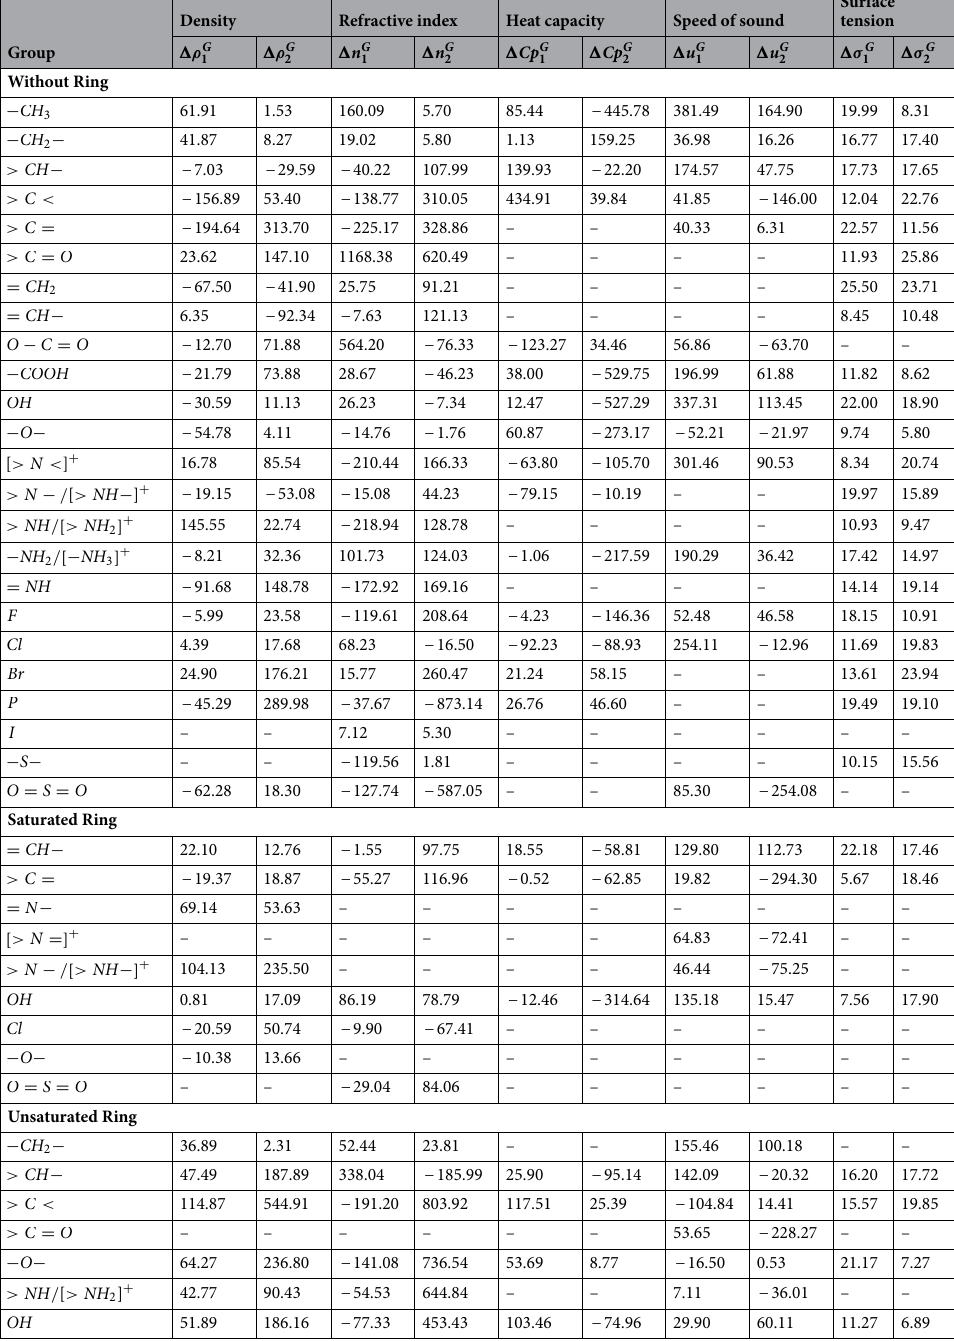
Table 2. The list of functional groups and their contributions for the GC models for density, refractive index, heat capacity, speed of sound and surface